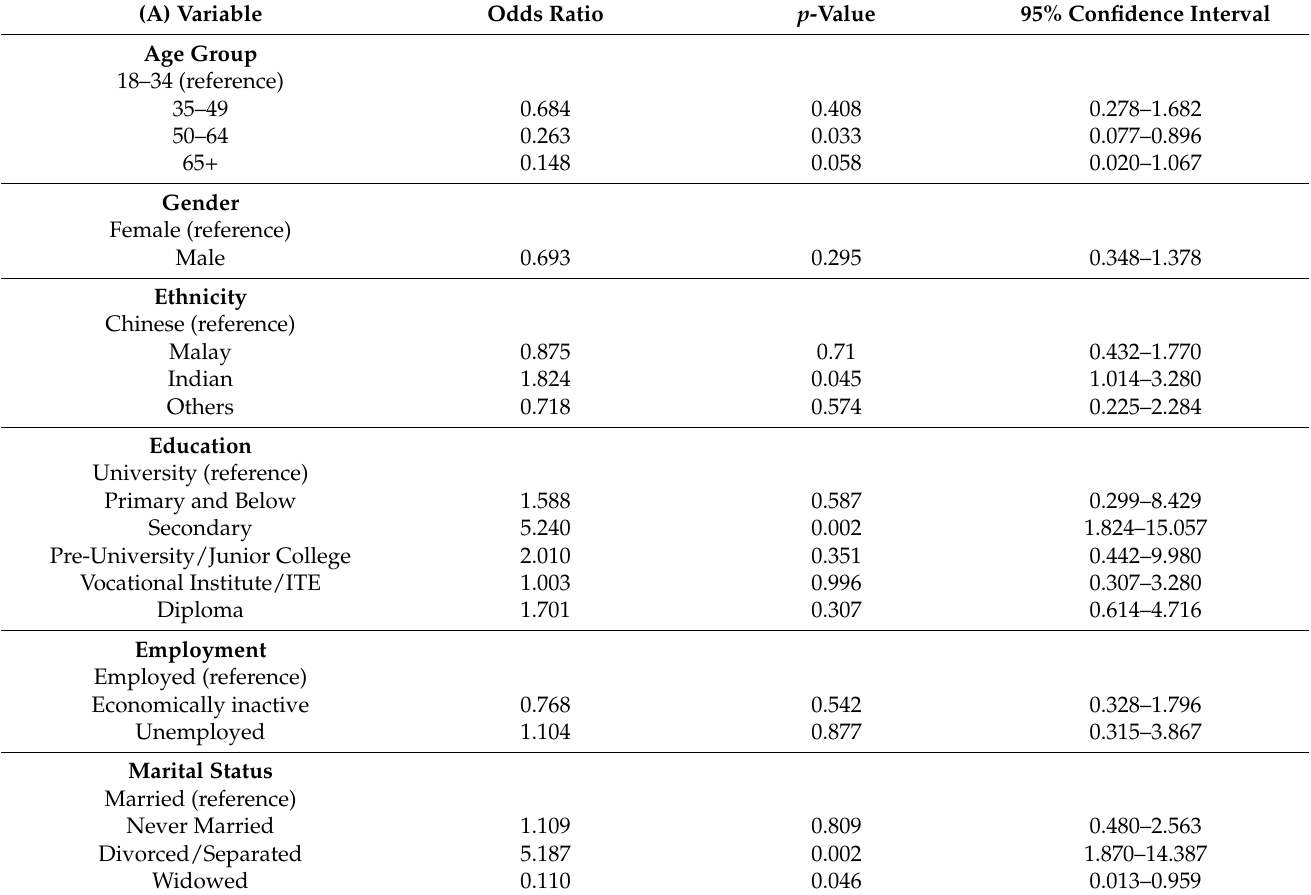
Table 4. ( A ) Socio-demographic factors of suicidal attempts. ( B ) Associations among suicidal planning, physical, and psychiatric